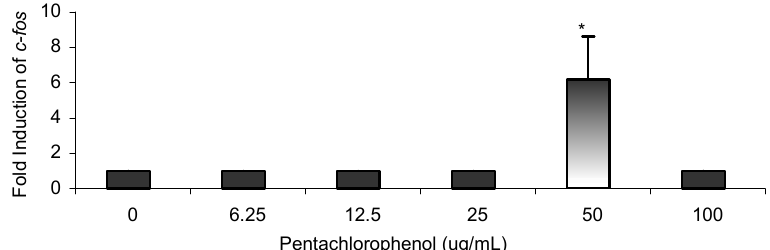
Figure 5. Fold induction of c-fos in HepG cells exposed to pentachlorophenol : Recombinant HepG 2 2 transfected with a c-fos gene promoter fused to the CAT protein were treated with serial dilutions of pentachlorophenol (0-100 µ g/mL). c-fos induction was based on the expression of the CAT-protein using a sandwich ELISA, as indicated in the methodology section. Bars are means + SDs, n=3. * Significantly different from control (0 µg/mL PCP), p < 0.05.